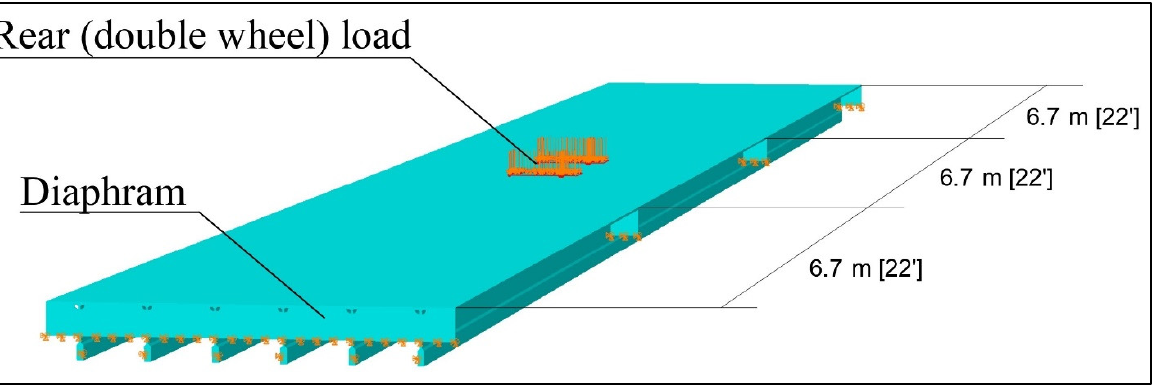
Figure 11. Three-span bulb section assembly of continuum case 1 with REI rear load.